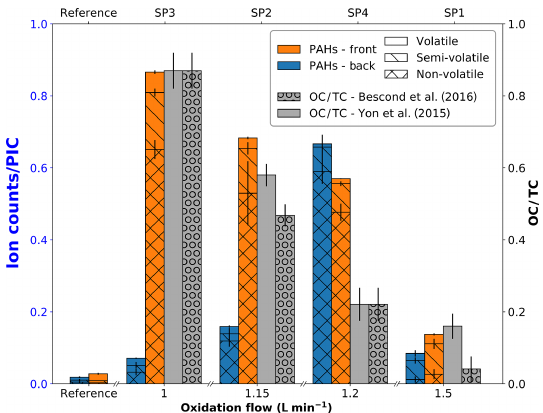
Figure 7. Total PAH signal detected with SIMS on front (orange) and back (blue) filters plotted as a function of oxidation air flow, along with OC / TC values reported in the literature for the same miniCAST set points. All values are normalized to the partial ion count (PIC) corresponding to the signal of all selected